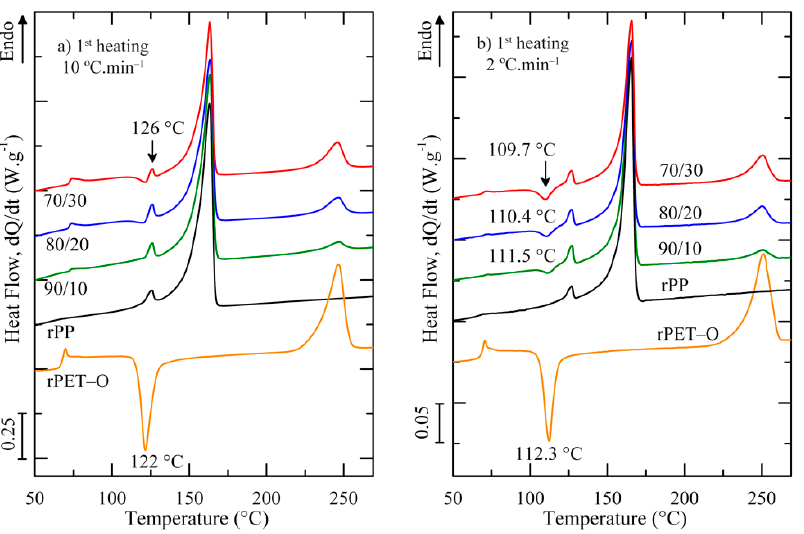
Figure 5. First heating DSC scans of rPP/rPET-O blends at ( a ) 10 °C.min − 1 and ( b ) 2 °C.min − 1 .